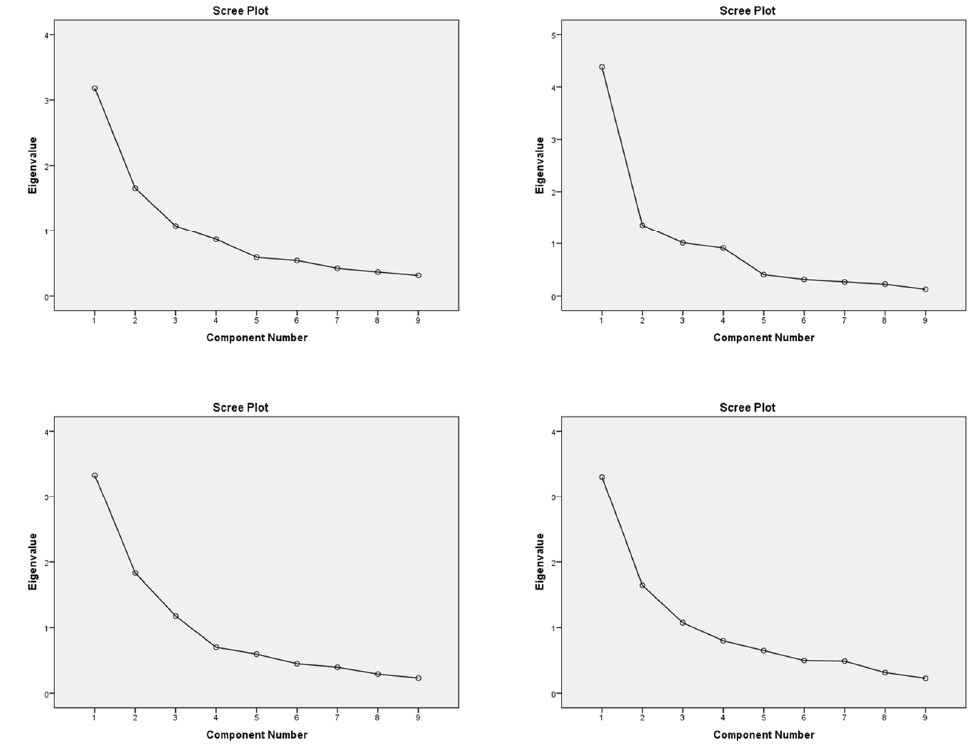
Figure 6. Cattell diagram of components and eigenvalues for the technical field.